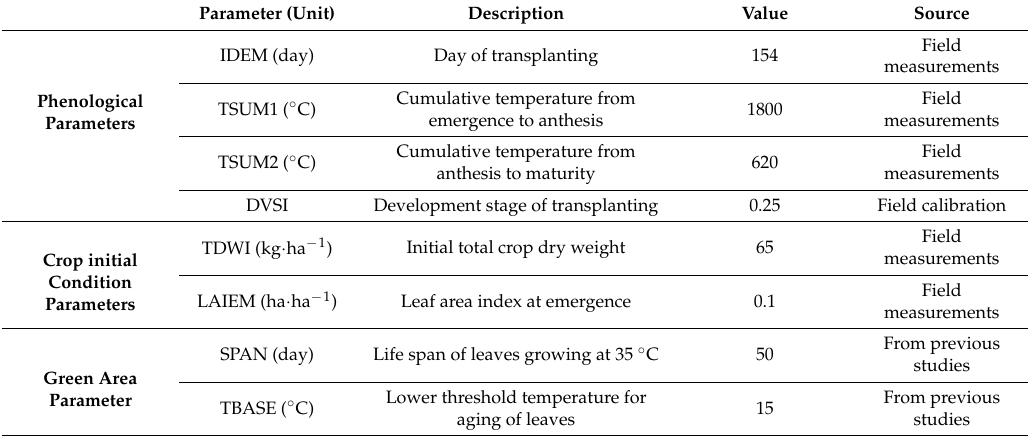
Table 2. The main initialization parameters used in the World Food Study Model.